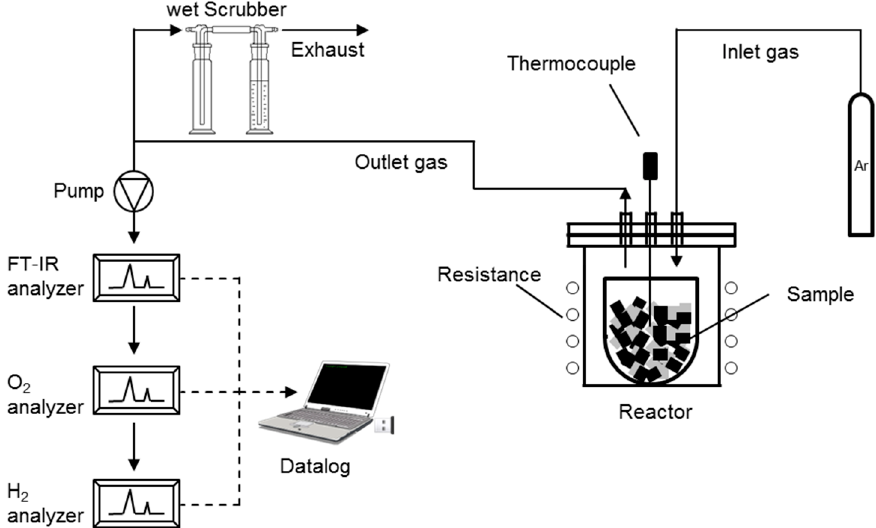
Figure 2. Experimental setup for the conventional pyrolysis test.